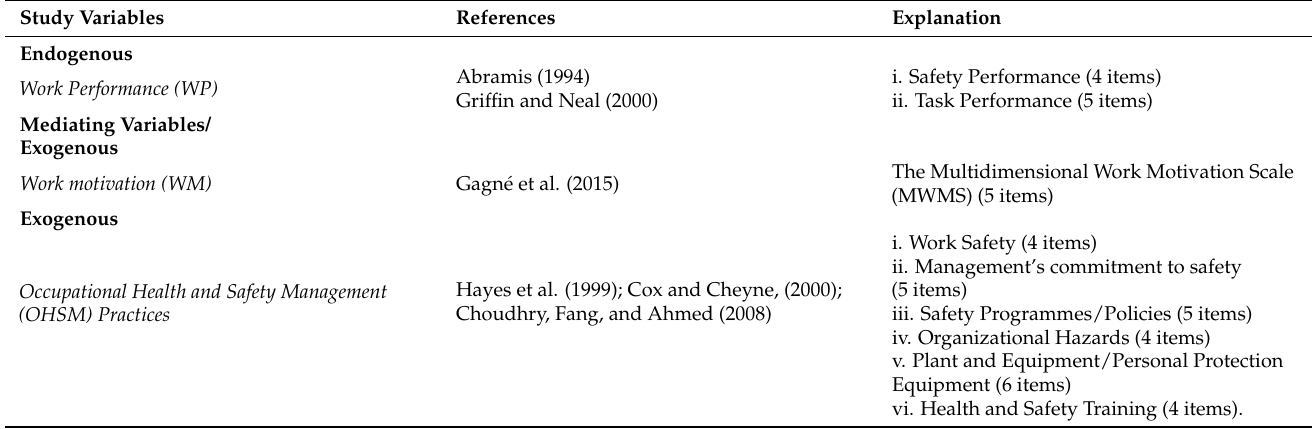
Table 2. Scale Items